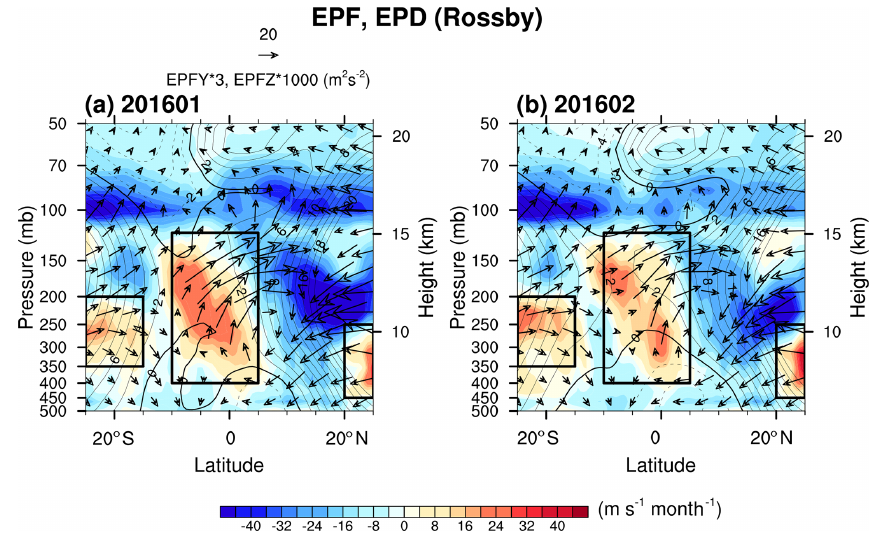
Figure 6. Latitude–height cross sections of the EP flux (vectors) divided by air density and EP flux divergence (shading) for the Rossby waves in (a) January 2016 and (b) February 2016. Note that below 100hPa, the L w waves ( ω ≤ 0 . 4cpd and − 20 ≤ k < 0) are assumed to be Rossby waves. Black boxes denote the three potential source